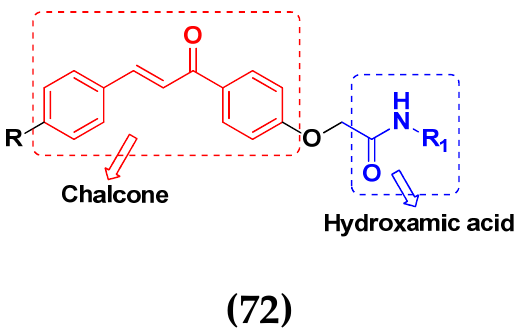
Figure 69. Structure of hydroxamic acid based chalcone derivatives ( 72 ). Table 57. In vitro cytotoxic activities of hydroxamic acid based chalcone hybrid compounds 72 ( a – d ).